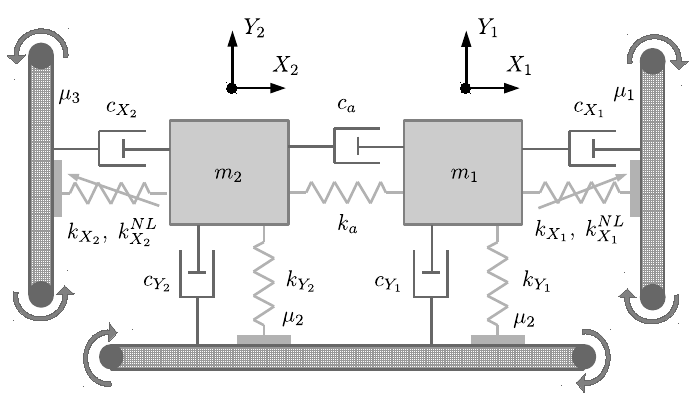
Figure 1. Mechanical system under